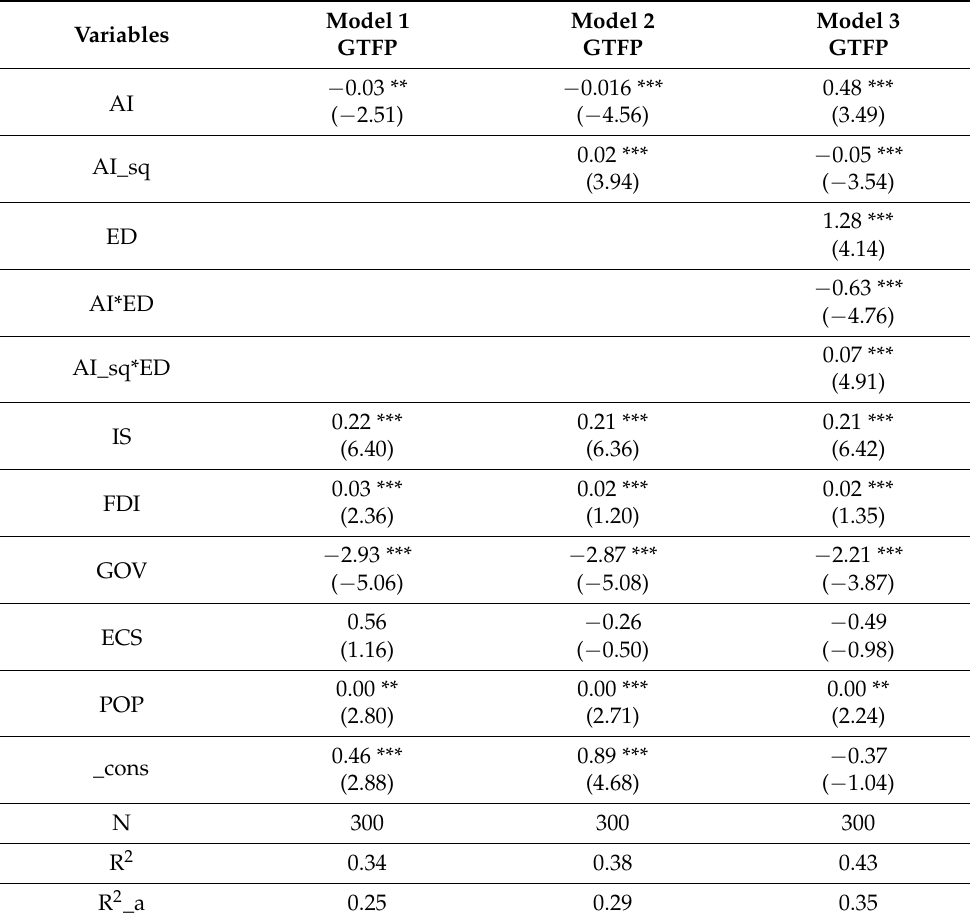
Table 3. Baseline regression